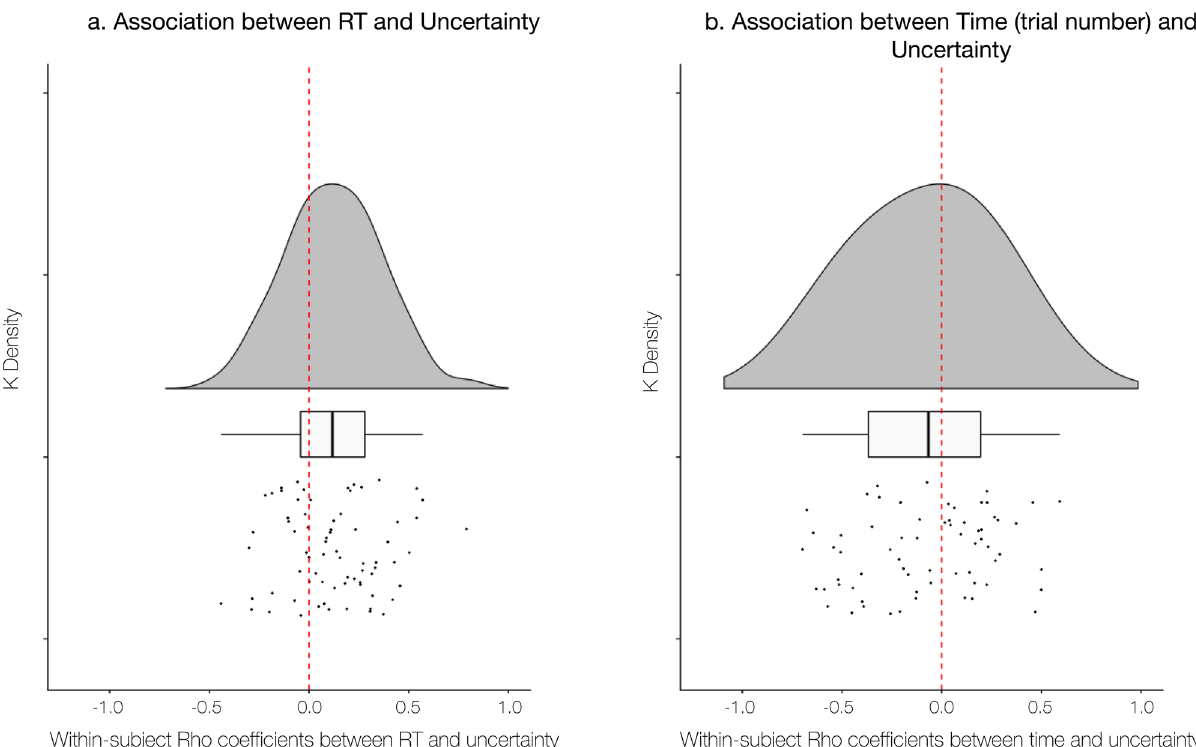
Figure 3. Distribution of within-subject associations between Reaction Time and Uncertainty & between Time and Uncertainty. Here we depict distributions of within-subject associations with uncertainty based on rho coefficients, smoothed with a kernel density function (top) with boxplot and individual subject’s rho coefficients below. Correlations were run between uncertainty and reaction time (RT) and between uncertainty and time across trials within each participant. We ran a one sample t-test against zero on the subject-level rho coefficients for each predictor respectively. ( a ) There was a positive association between uncertainty and reaction time ( M rho = 0.12, SD rho = 0.24, t (71) = 4.38, p < 0.001, CI [.07, .18]) such that participants took a longer time to rate their pain when they reported more uncertainty. ( b ) There was a negative association between uncertainty and time ( M rho = − 0.08, SD rho = 0.34, t (71) = − 2.05, p = 0.04, CI [− 0.16, − 0.002], such that participants reported less uncertainty on later trials (i.e. with more experience in the